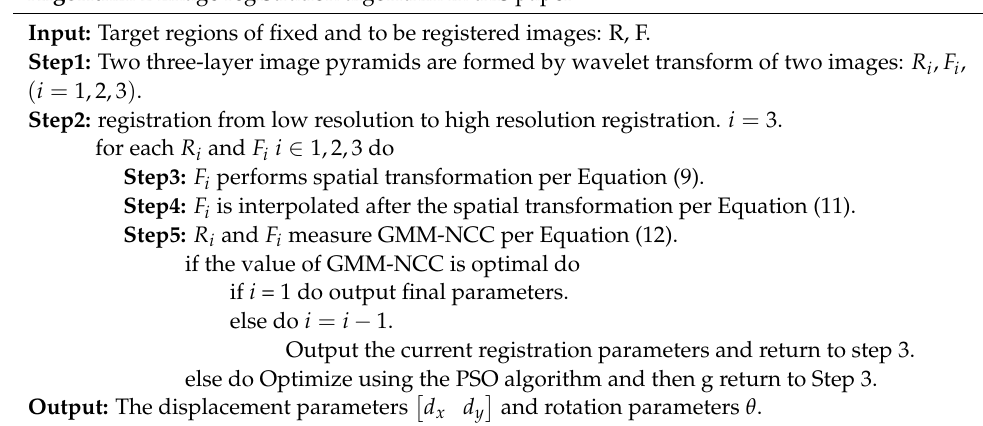
Algorithm 2 Image registration algorithm in this